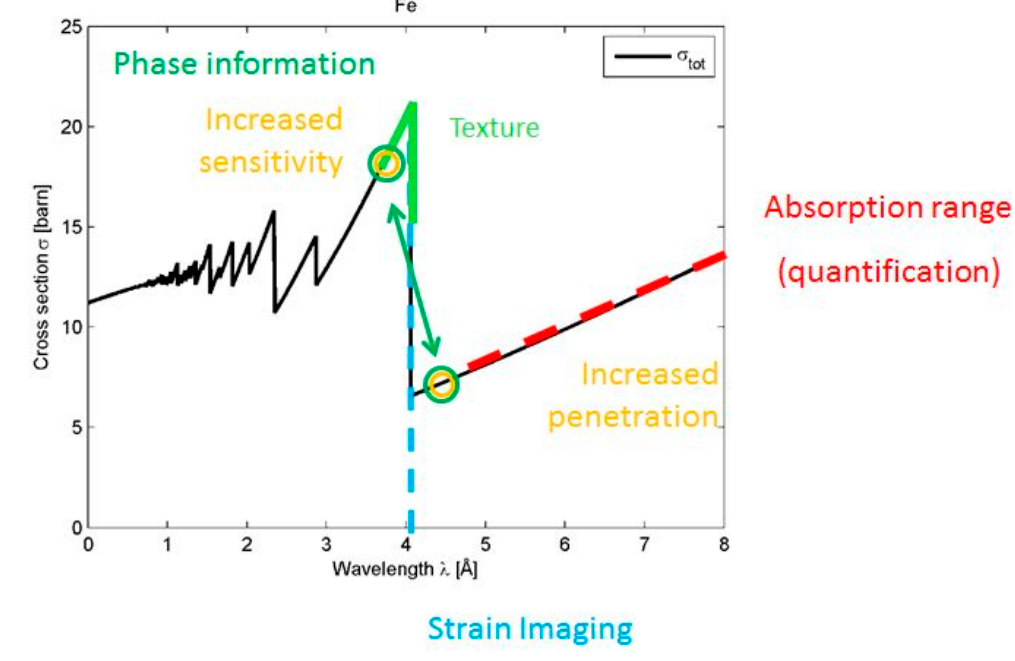
Figure 4. Options to use energy selective imaging near the Bragg edges of iron; there is mainly absorption above 4 Å while elastic scattering is not relevant for quantification anymore.